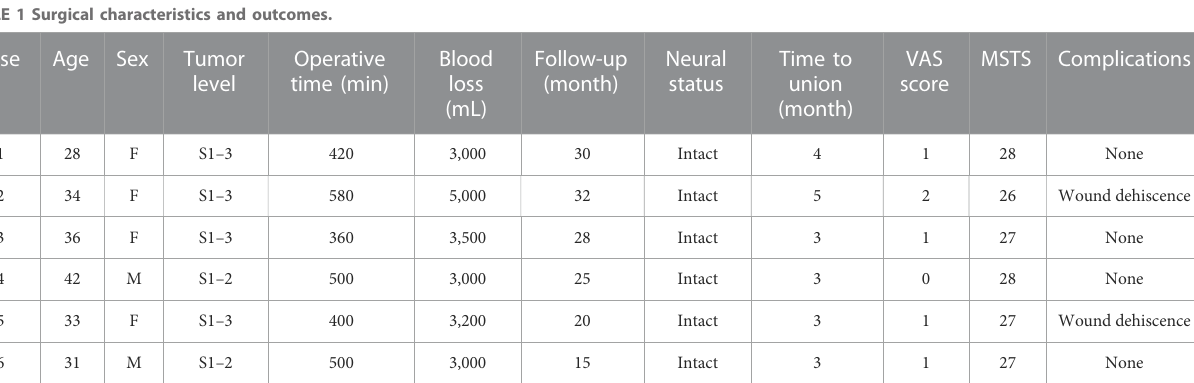
TABLE 1 Surgical characteristics and